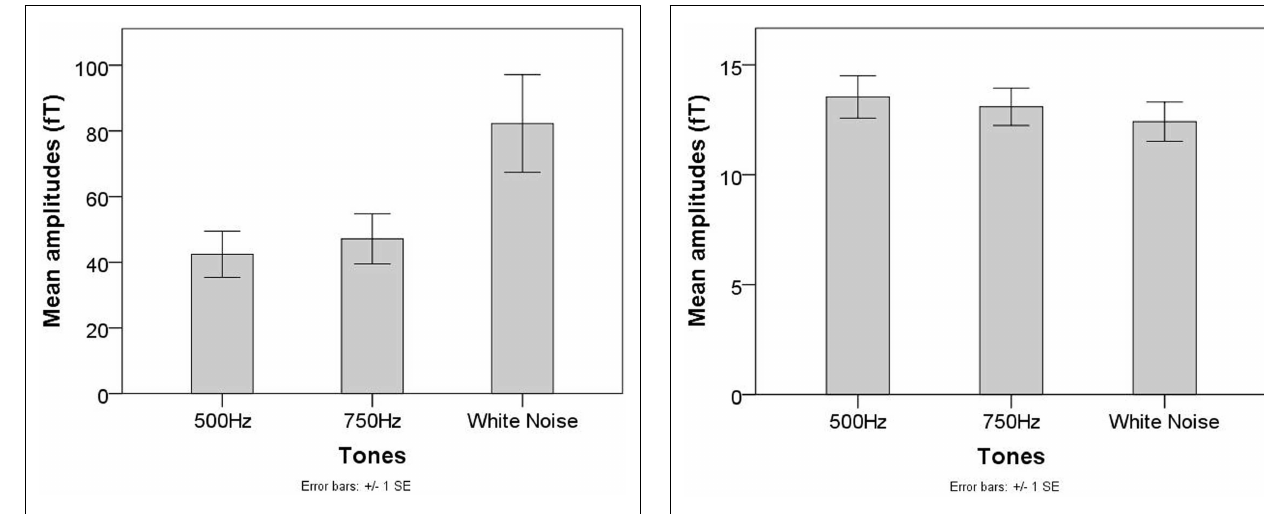
RESULTS FROM LITTLE ROCK STUDY (SECOND PART)